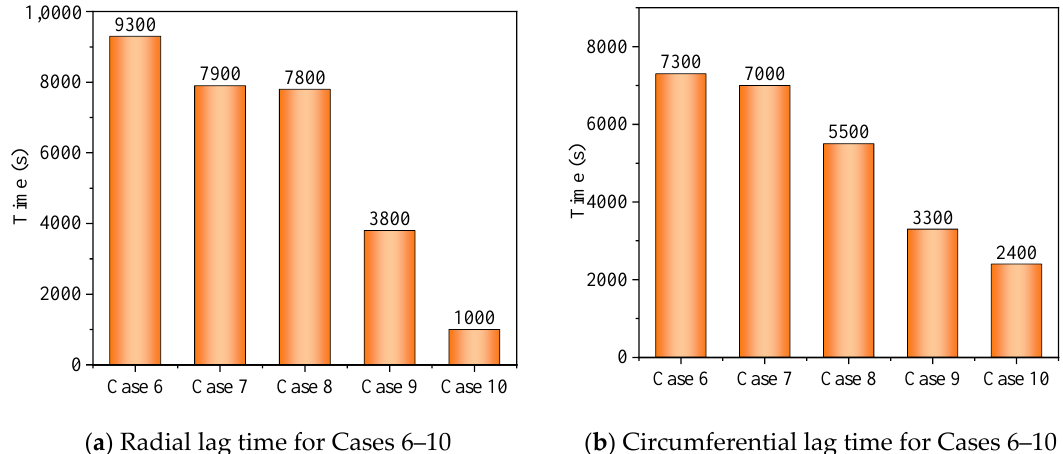
Figure 15. Thermal penetration and thermal uniformity for Cases 6 – 10.